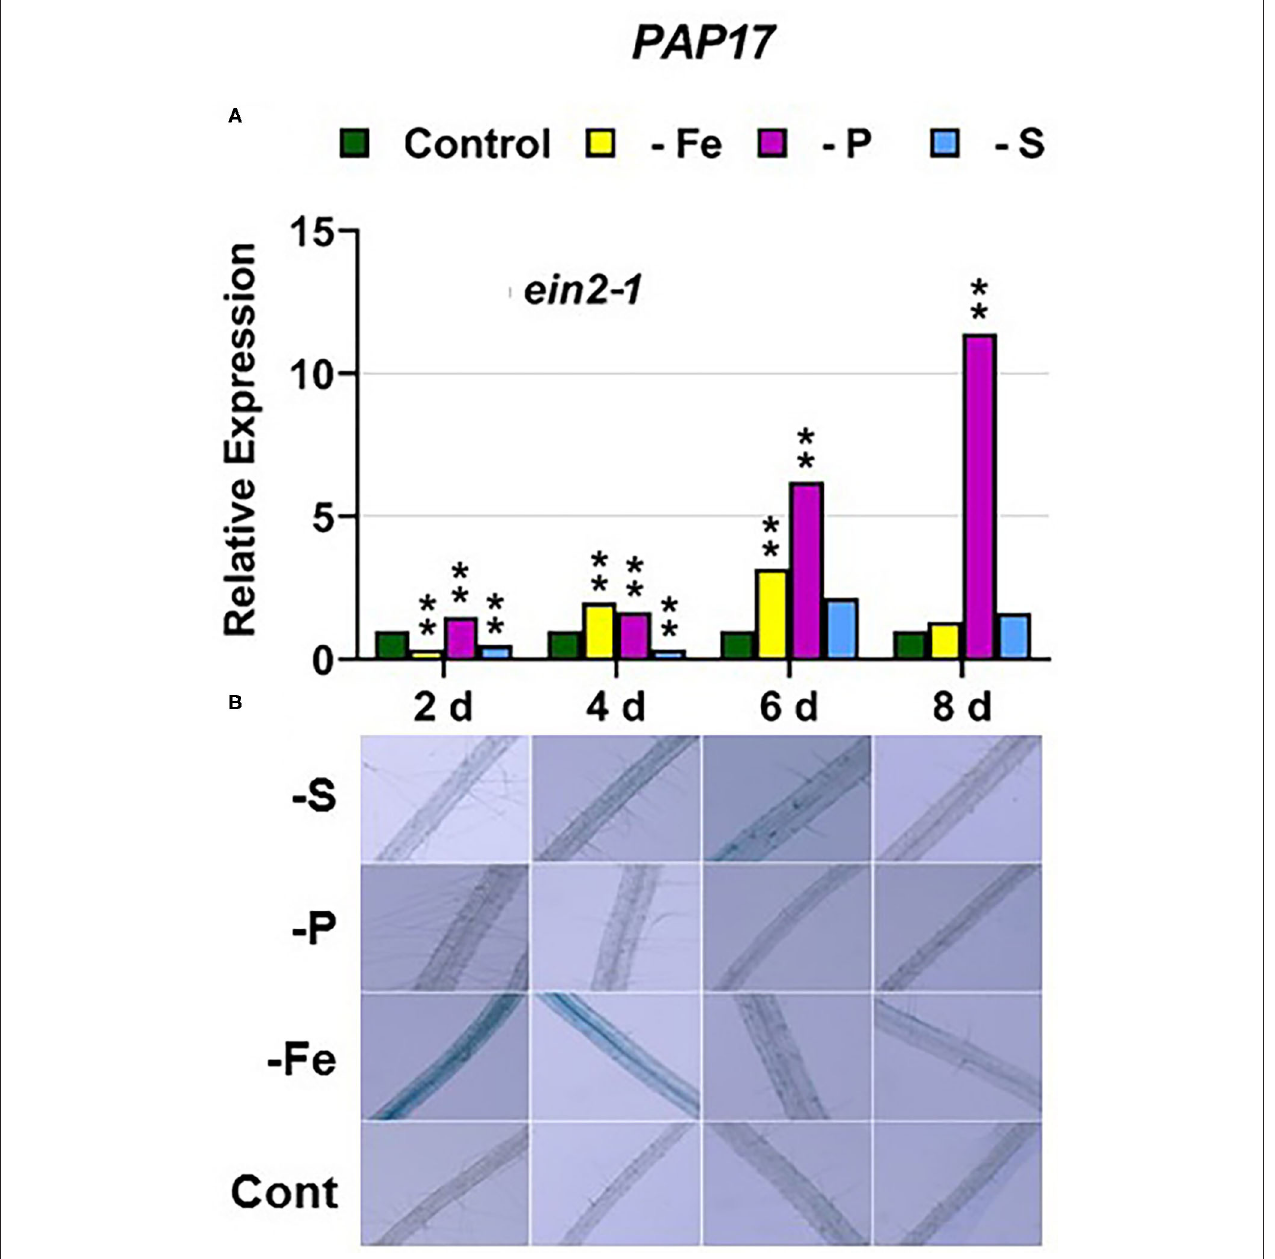
FIGURE 7 | Effect of Fe, P or S deficiency on the expression of the P-related gene PAP17 (A) ; and of phosphatase activity (PA; B ) in roots of the Arabidopsis ethylene mutant ein2-1 . Treatments and determinations as in Figure 5 . Within each day and genotype, * or ** indicate significant differences ( P < 0.05 or P < 0.01) in relation to the control